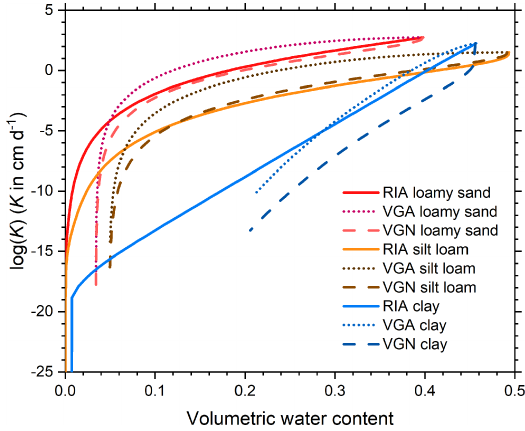
Figure 2. The unsaturated soil hydraulic conductivity curves de- rived from the fitted retention curves depicted in Fig. 1 and scaled by soil-specific values of the hydraulic conductivity at